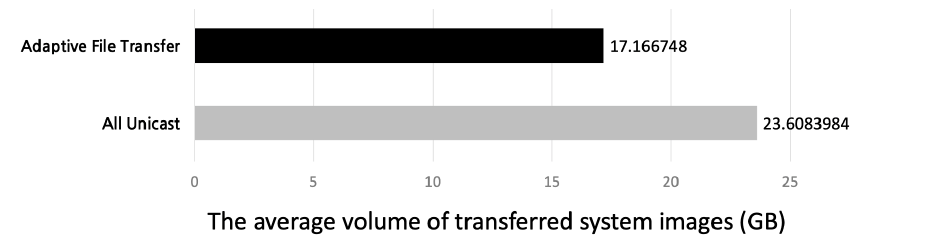
Figure 16. The average volume of transferred system images on the server ( Top ) using the adaptive file transfer or ( Bottom ) using only unicast.